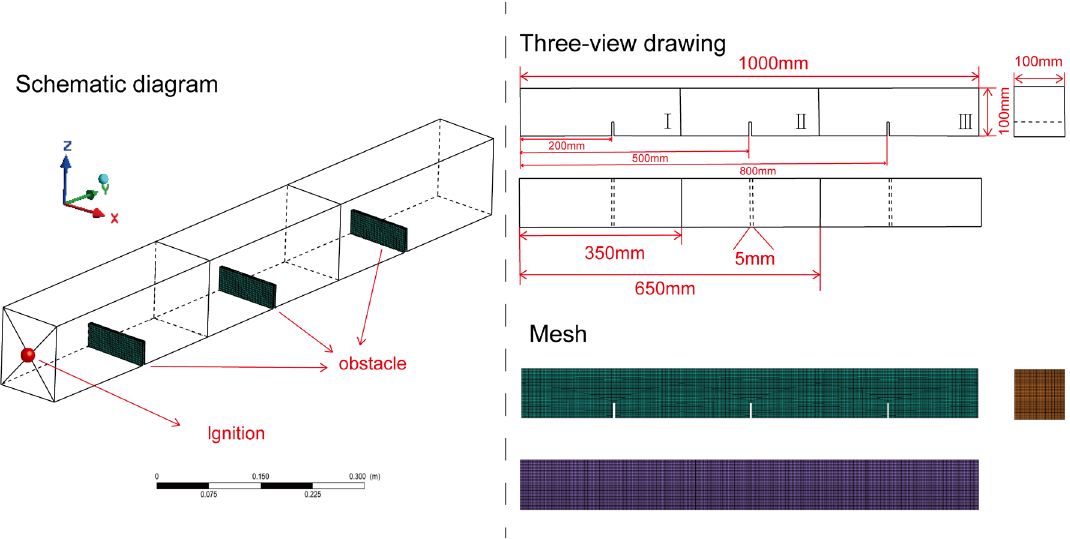
Figure 3. Three-dimensional mesh model and details.